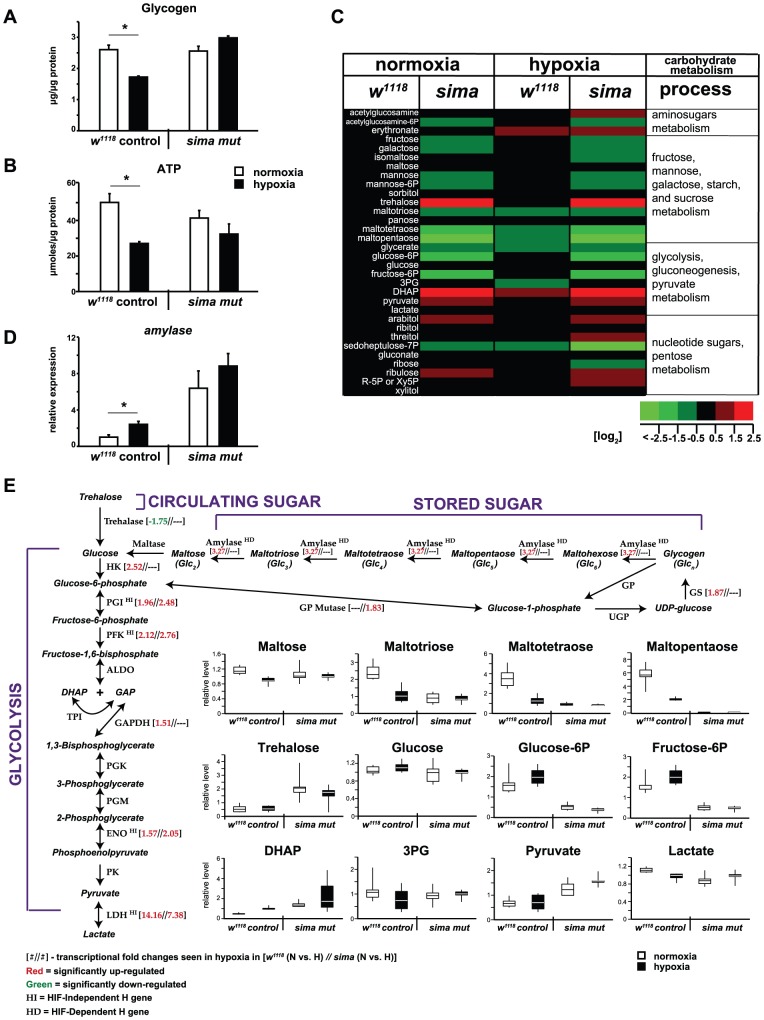
HIF-dependent effects on carbohydrate catabolism.(A) Unlike the w1118 response, sima mutants are not able to mobilize glycogen stores in response to 6-hr H-treatment in late-L3. (B) ATP levels are significantly depleted upon H-challenge by w1118 animals. Although sima animals showed a similar trend, the decrease observed was not significant. Levels of glycogen and ATP are normalized to total protein. (C) Shown is a metabolic heat map of individual metabolites measured by GC/MS or LC/MS from late-L3 w1118 animals or sima mutants subject to N (left two columns) or H (right two columns). Six replicates were measured for each treatment group. Each replicate has ∼250 independently collected and pooled animals. Metabolite levels are expressed as log2 transformations of the average values, which are plotted relative to the normoxic level obtained in the WT background. The data are normalized to total protein content. Red indicates an elevated metabolite level, green indicates a diminished level, and black no/little change. See Table S2 for further information and statistics. (D) qRT-PCR analysis showing amylase expression increases in hypoxia in control animals. Although sima mutants have an elevated constitutive level of amylase expression, they do not induce expression in hypoxia. (E) Integrated snapshot of the transcriptional and metabolic response to hypoxia at 6-hr. Shown, are the metabolites and enzymes of stored sugar and circulating sugar as they feed into glycolysis. When significant H-induced changes were noted (fold-change >1.5, FDR <1%) for transcripts in microarray experiments, those changes are noted in brackets next to the enzyme names. HD or HI status, as classified in Table S1 is also noted. Metabolite levels from mass spec analysis are additionally shown as box and whisker plots. The upper and lower boundaries of the box note the upper and lower quartile values, while the ends of the vertical line indicate the maximum and minimum values. The average value is the noted by the horizontal line within the box. Error bars are the SEM. * = p-value<0.05.